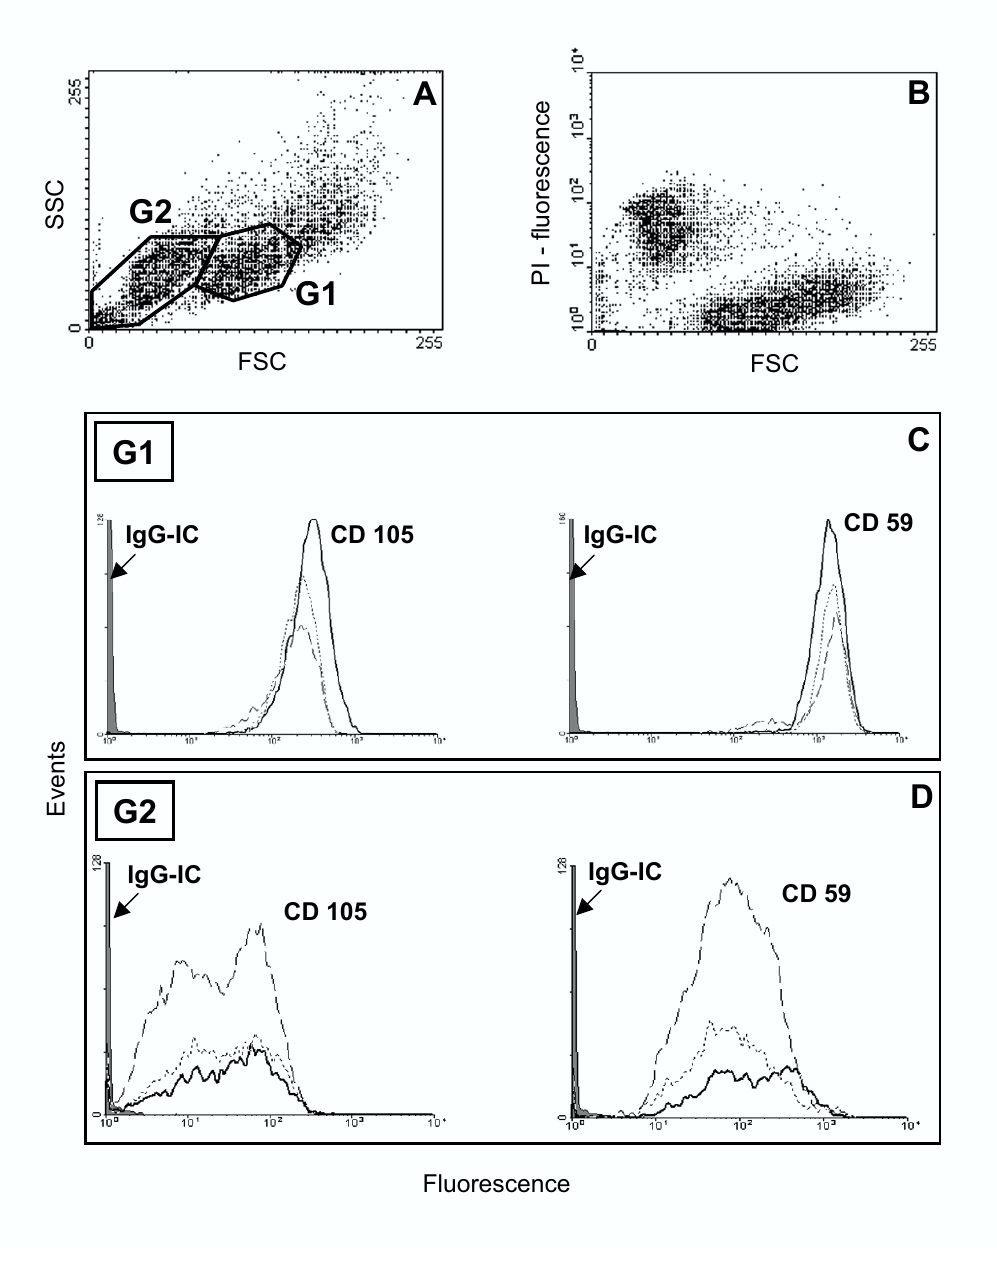
Figure 5 Expression of CD59 and CD105 on endothelial cells and apoptotic bodies in HUVEC culture treated with camptothecin Confluent HUVEC at 48 hrs in culture were treated for 24 hrs with 0.5% DMSO, 500 nM or 5 µ M CPT in medium. After treatment the cell culture supernatant was pooled with harvested adherent cells. Mixture of cells, apoptotic bodies and other cell fragments was labeled with propidium iodide (PI) or with PE-labeled Mabs to CD59 or CD105 and ana- lyzed by flow cytometry. Forward scatter (FSC) vs. side scatter (SSC) plot (A) shows gated intact single cells (G1) and apop- totic bodies and other cell fragments (G2) in a sample treated with 0.5% DMSO alone. PI – fluorescence vs. FSC plots of this sample is shown (B). Histograms showing expression of CD105 and CD59 on cells (C) and cell fragments (D) from HUVEC treated with 0.5% DMSO (solid line), 500 nM CPT (dotted line) or 5 µ M CPT (dashed line) are shown. Binding of the IgG2a isotype control (IgG-IC) corresponded to the fluorescence of nonlabeled cells and cell fragments. Results are representative of three